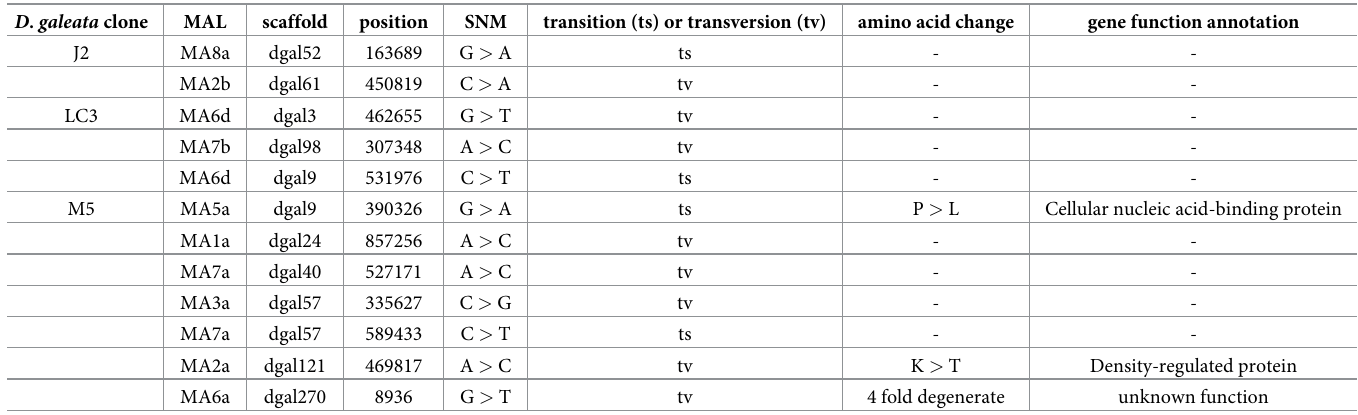
Table 2. List of single nucleotide mutation positions, their characteristics and